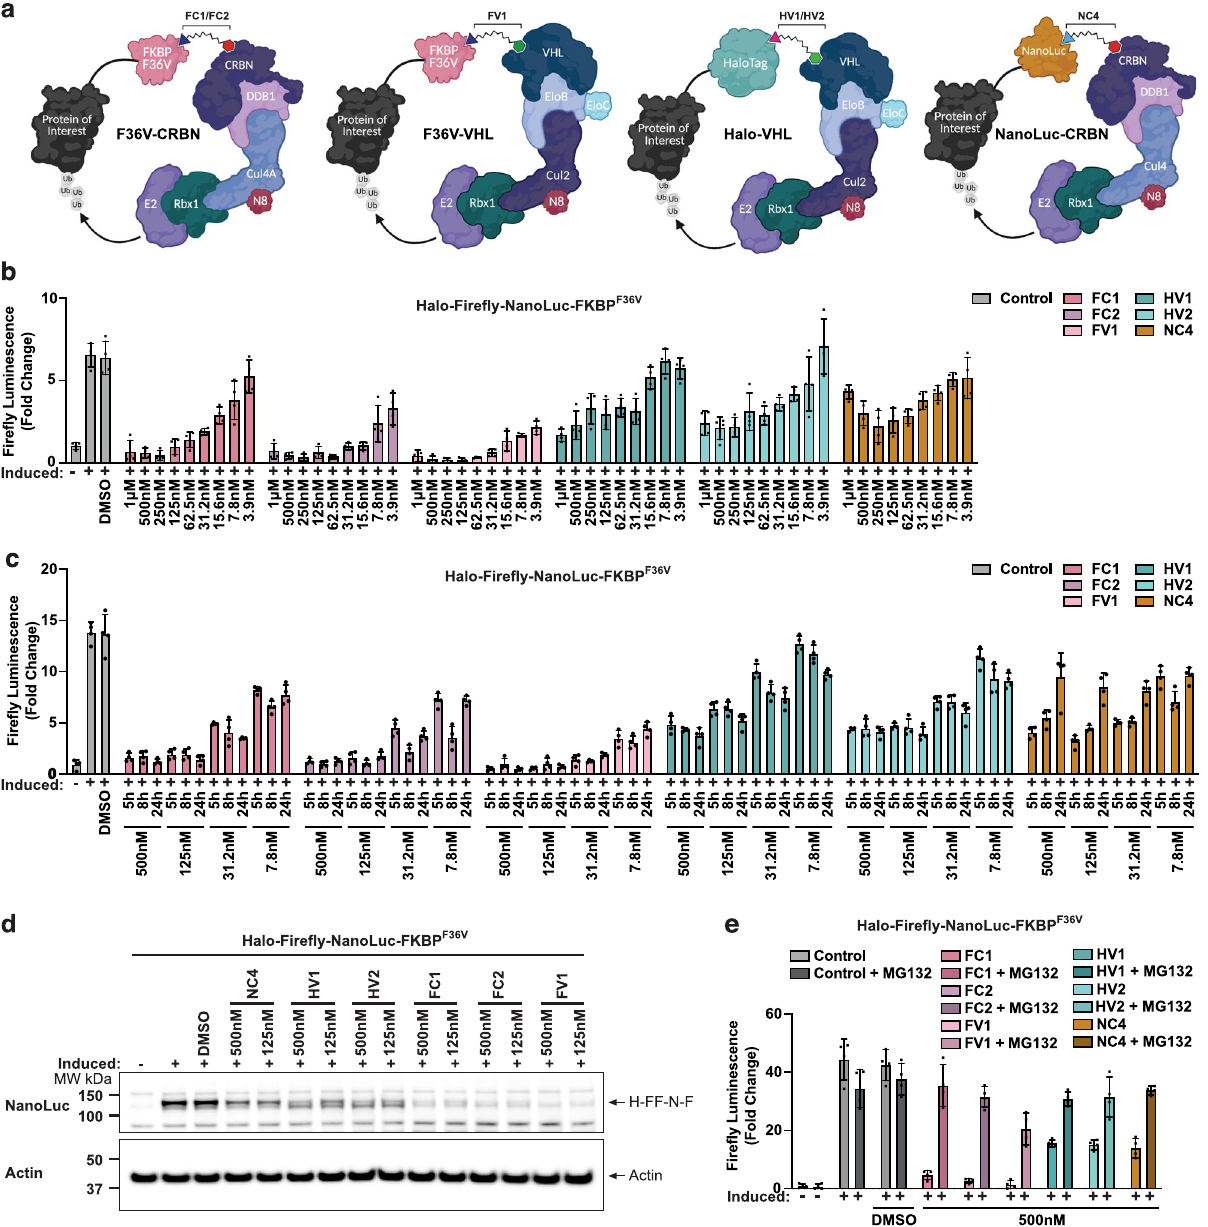
Fig. 3 FKBP F36V tTPD systems outperform other tTPD systems. a Schematic representation of the Halo-VHL, F36V-CRBN, F36V-VHL and NanoLuc- CRBN tag-targeting degrader systems. b Fire fl y luminescence from 293 T cells stably expressing doxycycline-inducible H-FF-N-F, treated with 20 ng/mL doxycycline overnight (induced), then stimulated with the indicated concentrations FC1 (F36V-CRBN), FC2 (F36V-CRBN), FV1 (F36V-VHL), HV1 (Halo- VHL), HV2 (Halo-VHL) or NC4 (NanoLuc-CRBN) for 5 h. c Fire fl y luminescence from cells used in b , treated with 20 ng/mL doxycycline overnight (induced), then stimulated with the indicated concentrations FC1, FC2, FV1, HV1, HV2 or NC4 for the indicated times. d Western blot analysis of total cell lysates from cells expressing H-FF-N-F, treated with 20 ng/mL doxycycline overnight (induced), then stimulated with the indicated concentrations of degraders for 5 h. e Fire fl y luminescence from cells in b , treated with 20 ng/mL doxycycline overnight (induced), following treatment with 20 μ M MG132 for 1 h prior to stimulation with the indicated concentrations FC1, FC2, FV1, HV1, HV2 or NC4 for 5 h. b , c , e EB represent mean ± SD from N = 4 technical repeats. All experiments were repeated independently three times, and a representative Fig. is shown. Source data are provided as a Source Data fi